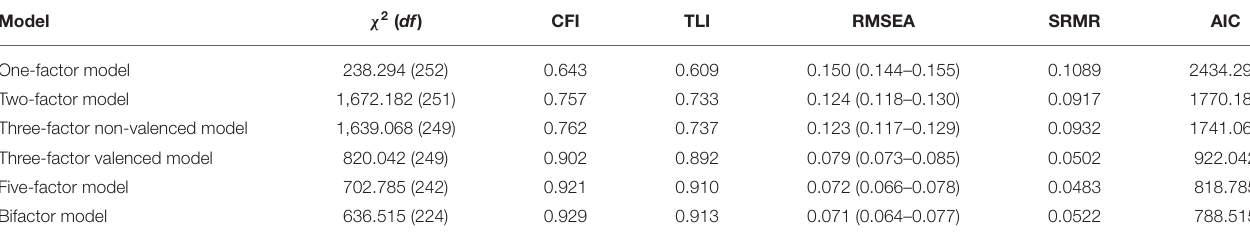
TABLE 1 | Goodness-of-fit index values for the different confirmatory factor analysis models of the Perth alexithymia questionnaire.